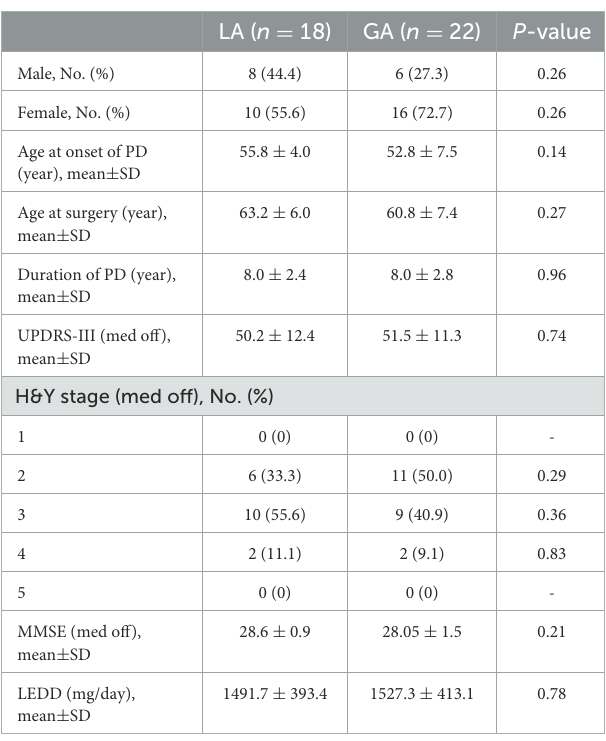
TABLE 1 Demographics and baseline characteristics of PD